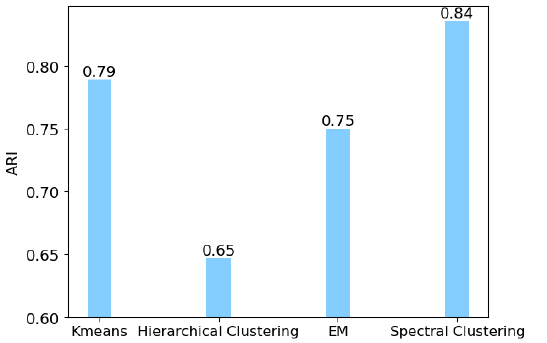
Figure 2. Performance comparison of different clustering methods. Adjusted rand index (ARI) is employed to measure the accuracy of clustering